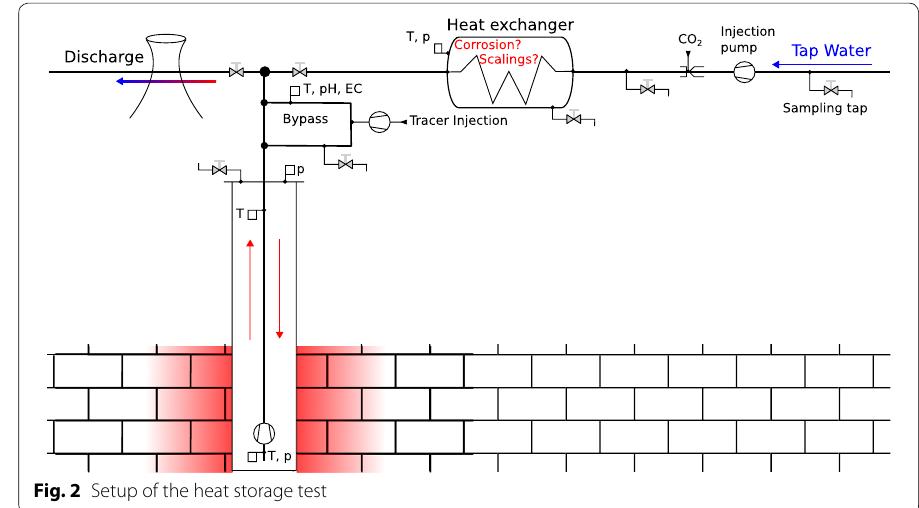
Fig. 2 Setup of the heat storage test